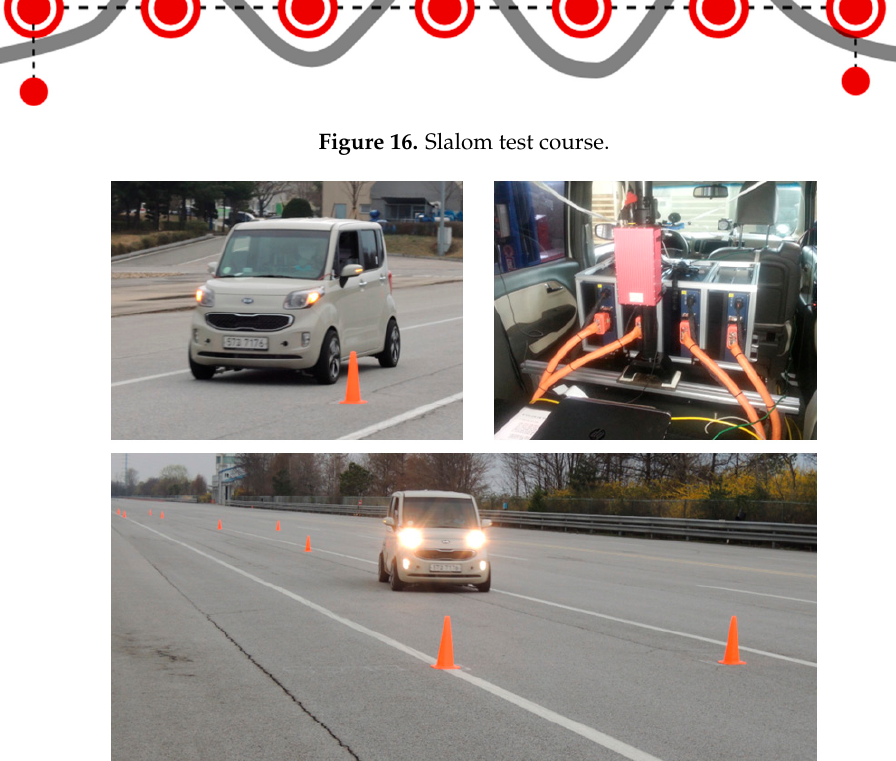
Figure 17. Slalom test and measuring sensor.